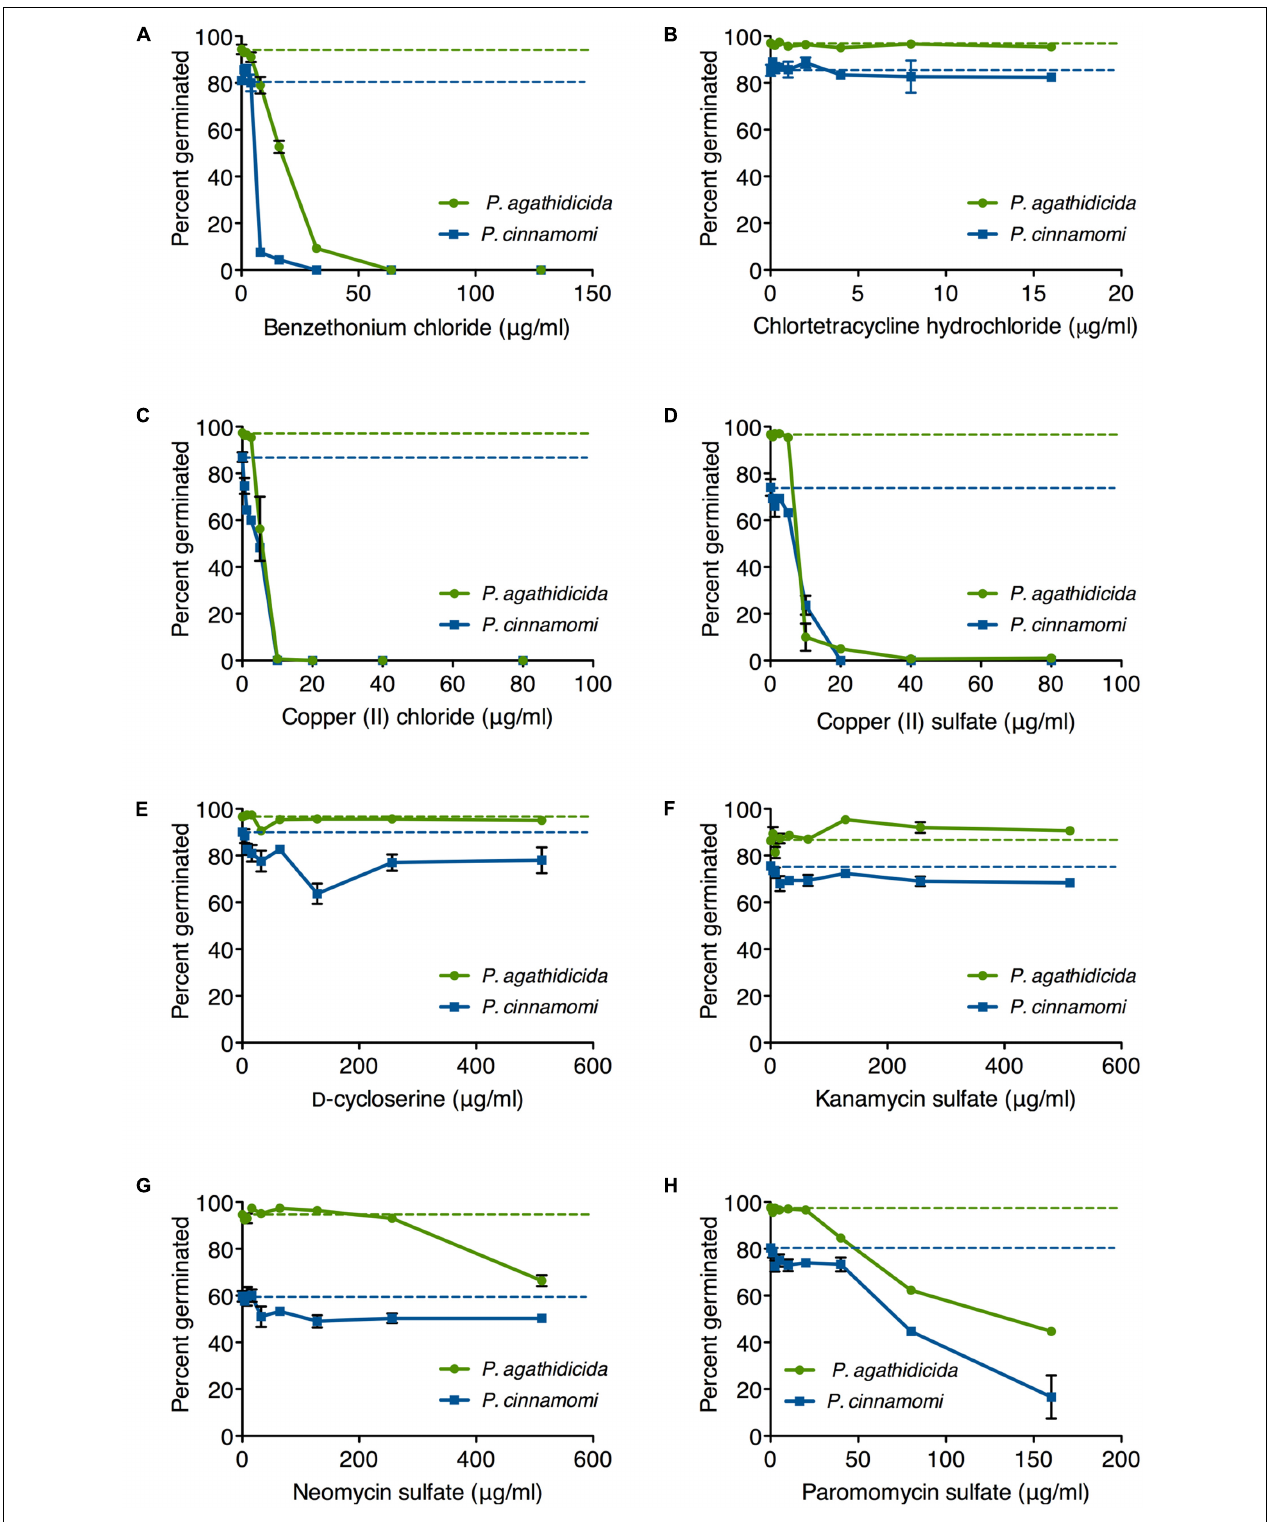
FIGURE 3 | Inhibition of zoospore germination in P. agathidicida (green) and P. cinnamomi (blue). Each panel (A–H) shows the inhibition curves for a single compound, as identified in the label on the x -axis. Dashed lines represent the germination rates on unamended agar. Data points are mean values from triplicate germination assays. Error bars are ± standard error of the mean. Where error bars are not visible, they are smaller than the symbol.